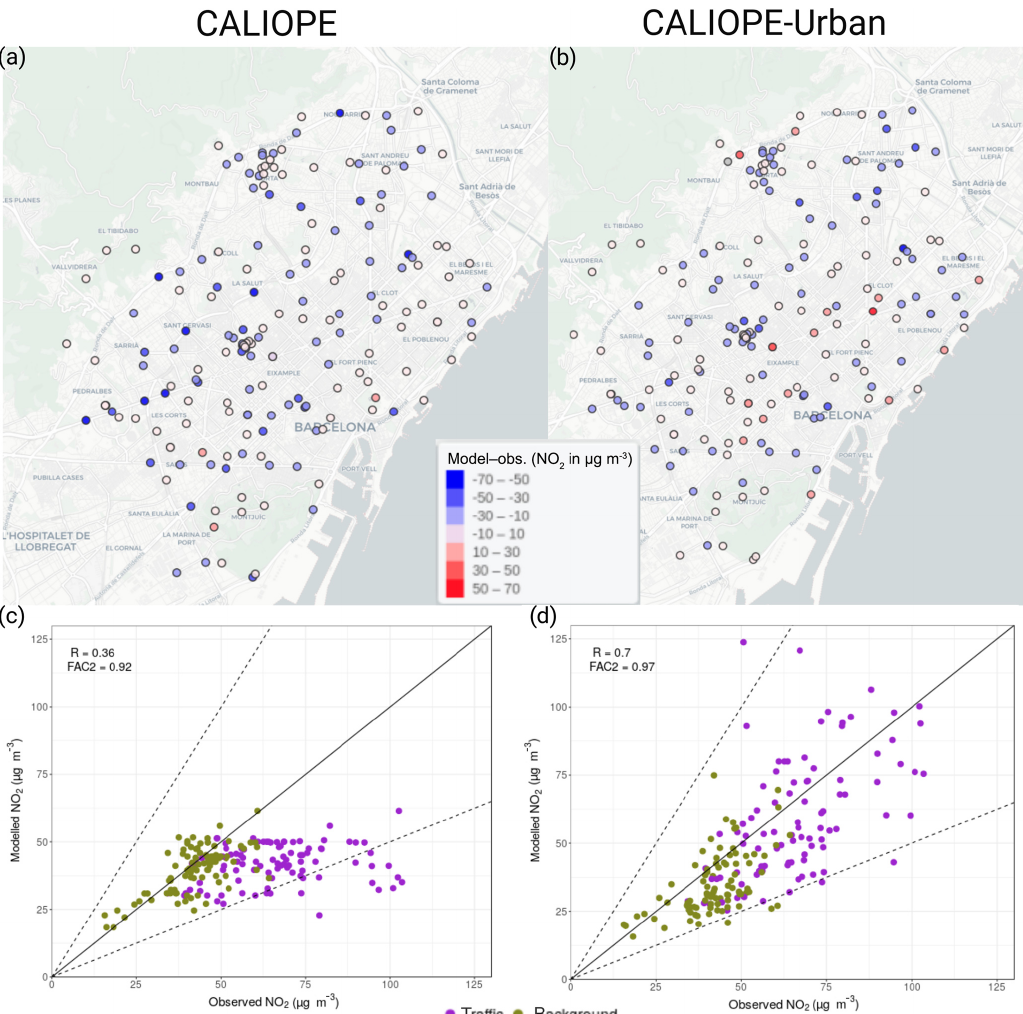
Figure 10. (a, b) NO 2 concentration difference (model – observations) for 2-week averaged values during the dosimeter campaign in 2017; CALIOPE is left (a) and CALIOPE-Urban is right (b) . (c, d) Scatter plot of modelled vs. observed concentrations with colours representing site type (olive green for background and purple for traffic) for CALIOPE (c) and CALIOPE-Urban (d) . Correlation ( R ) and agreement factor of 2 (FAC2) are computed for all